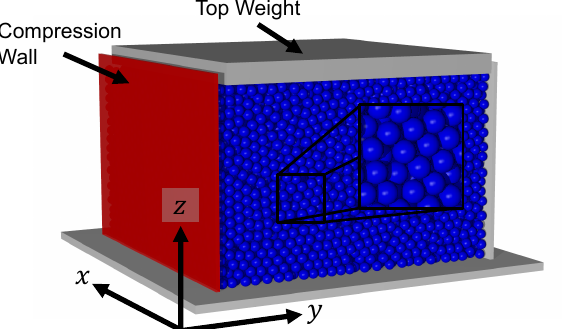
Figure 1. Schematic of the simulation setup. 20,000 spheres are confined in a box of side length 15 cm. The red wall com- presses the system from 0 (decompressed) to an amplitude A (compressed), along the y axis, then back to 0. A top weight is used for constant